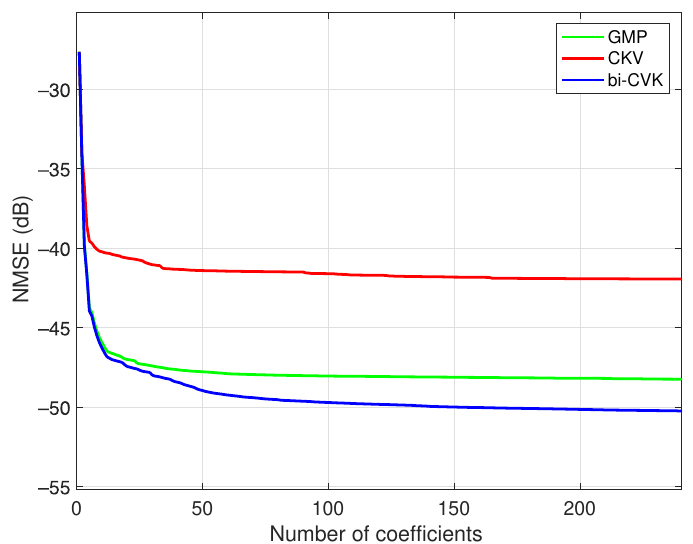
Figure 8. Identification NMSE in the search of the optimum DPD structure with respect to the number of selected components for the GMP and the CKV models in its conventional and bivariate versions. A class AB PA at 3.6 GHz was employed with an operation point characterized by an average output power of 31.2 dBm.